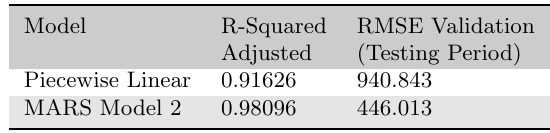
Table 3: Goodness of fit results for the piecewise and MARS